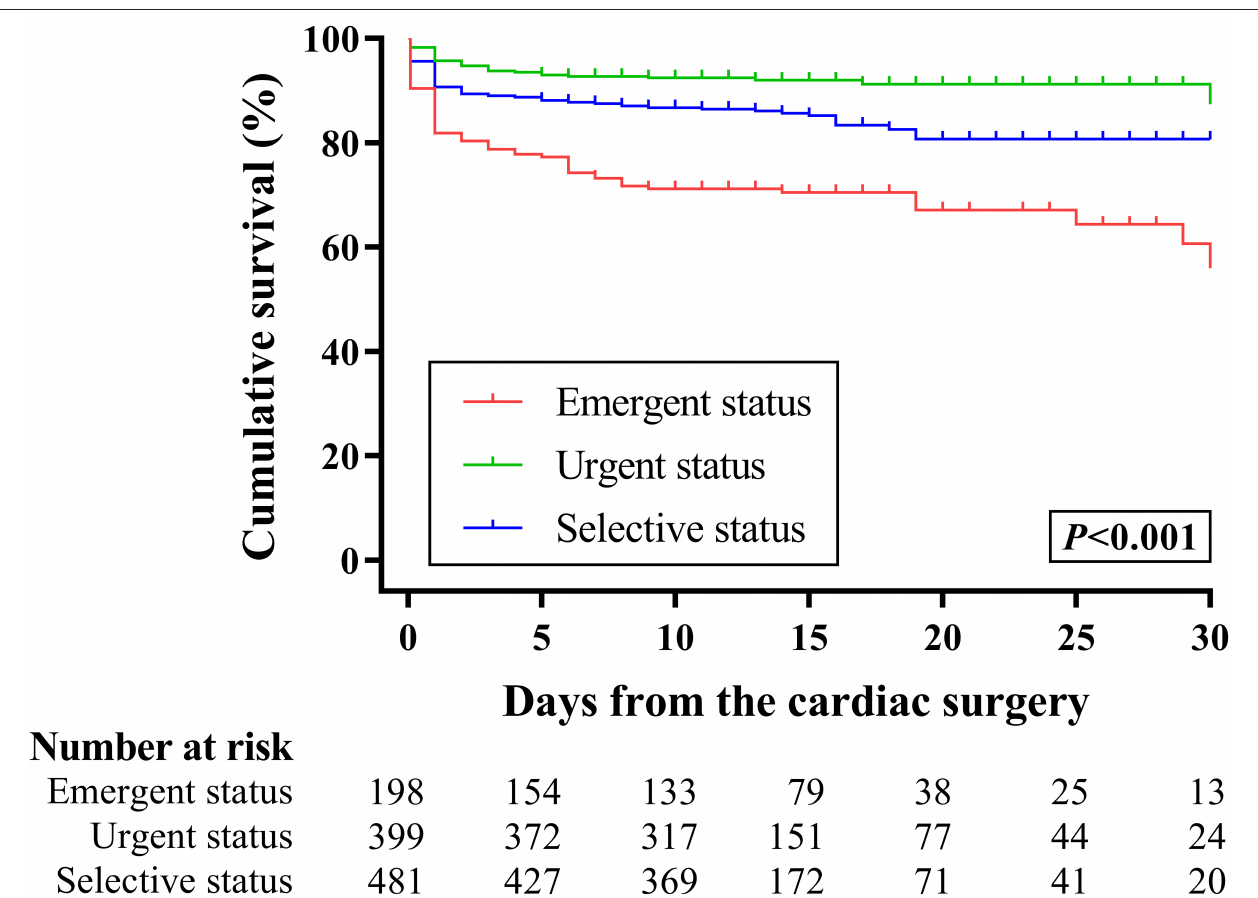
FIGURE 4 | Kaplan-Meier analysis for the 30-day survival of neonates with congenital heart diseases according to their preoperative health